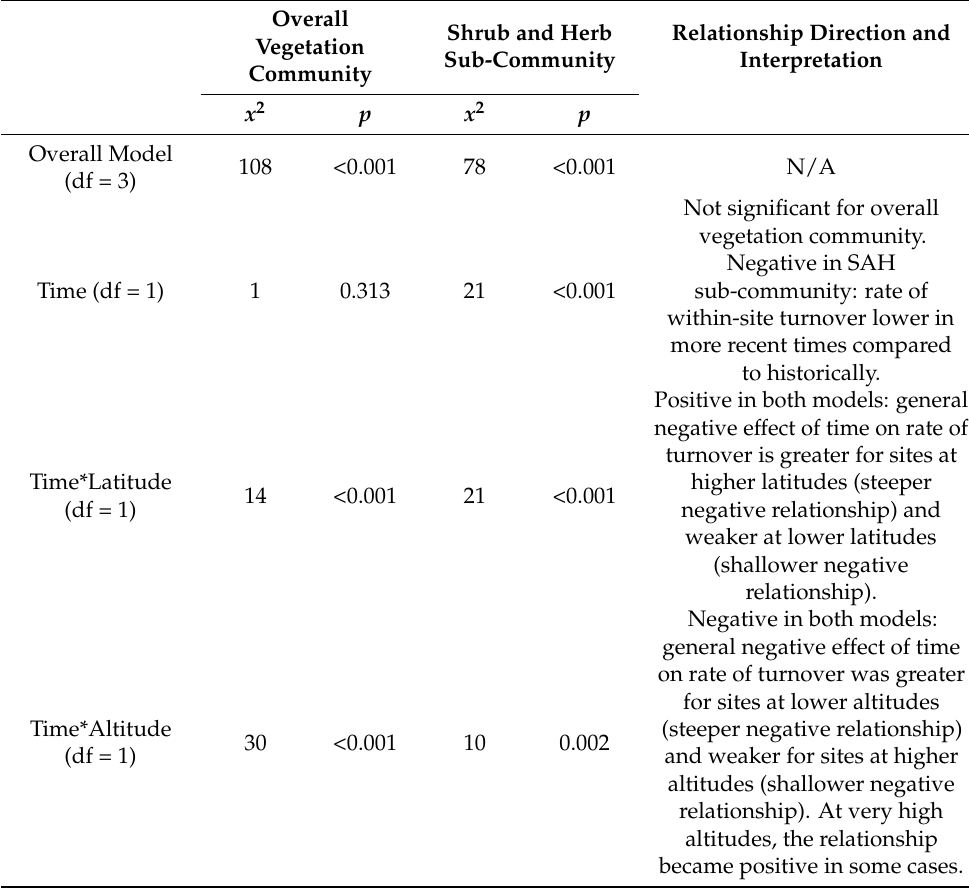
Table 2. Generalised Linear Models of within-site turnover in relation to time and mediating effects of latitude and altitude. Chi square values are likelihood ratio for overall models and Wald for factors and interactions. Overall Shrub and Herb Relationship Direction and Vegetation Sub-Community Community